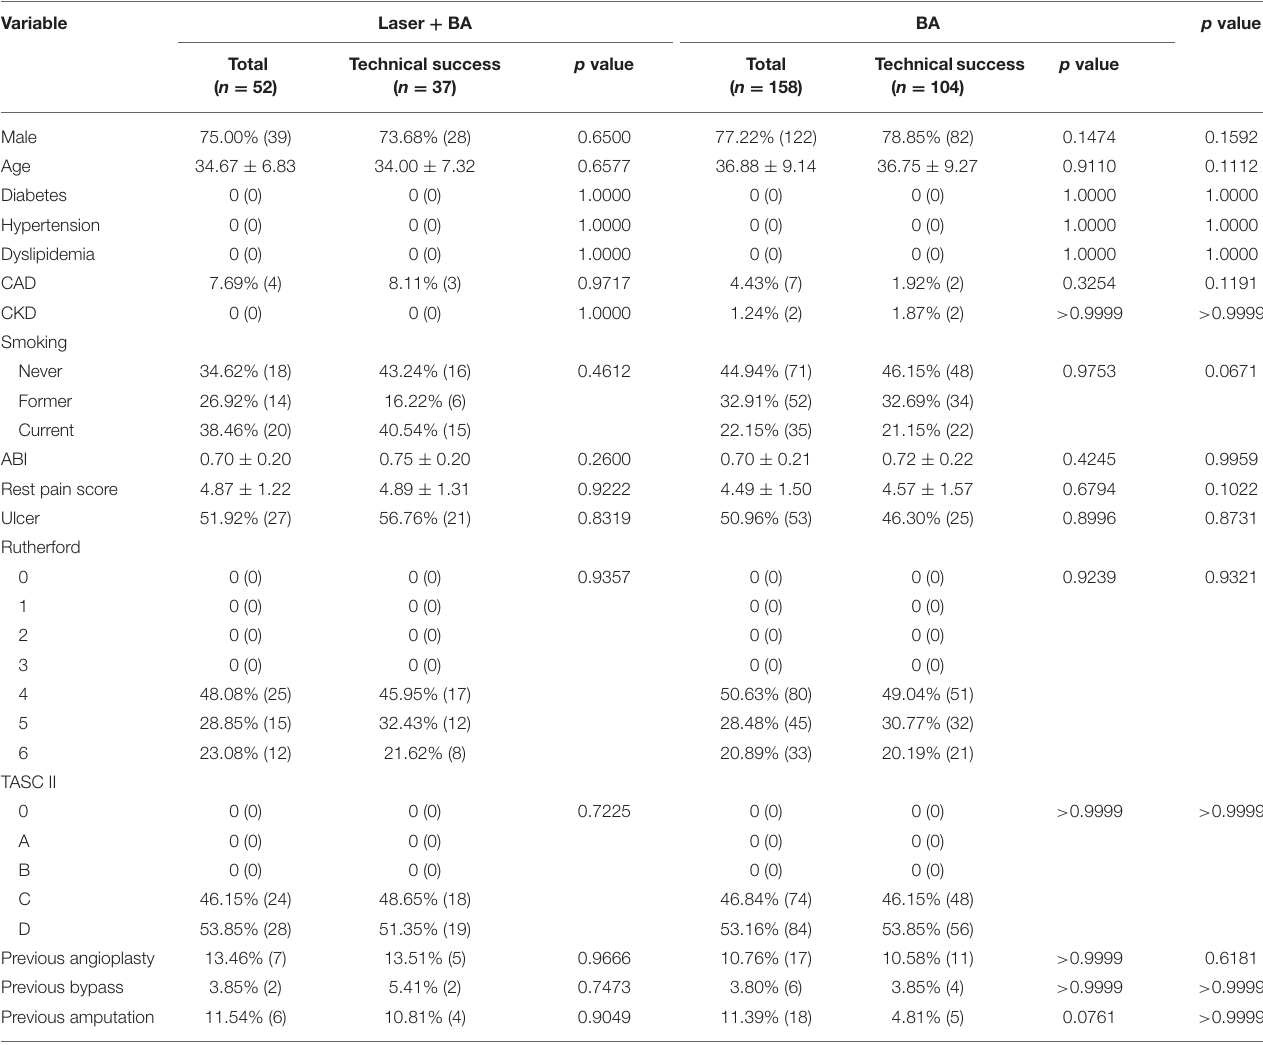
TABLE 1 | The general characteristics of involved patients.